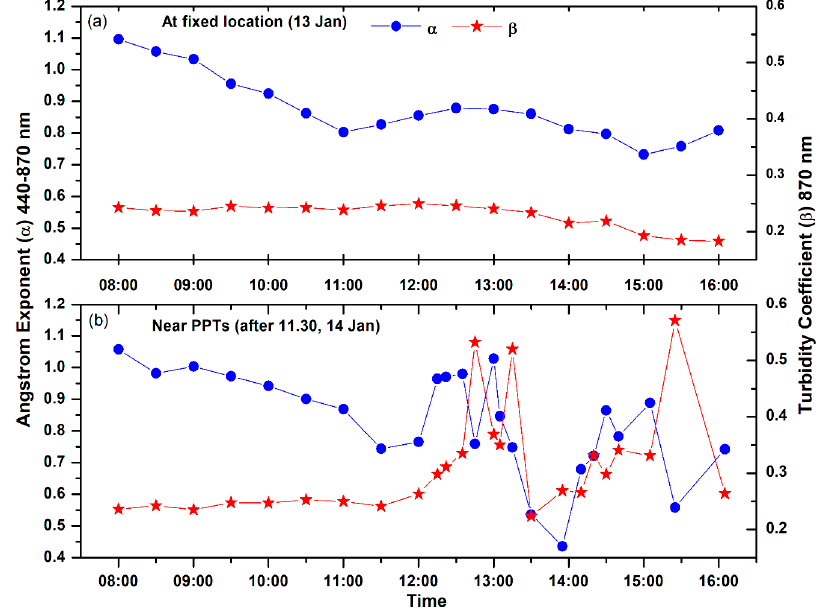
Figure 8. ( a ) Variation of Angstrom exponent ( α ) and Turbidity coefficient ( β ) at the fixed campaign site. ( b ) Same as Figure ( a ), but for the in-situ measurement (after 11:30) near the thermal power plants and coal mining areas.